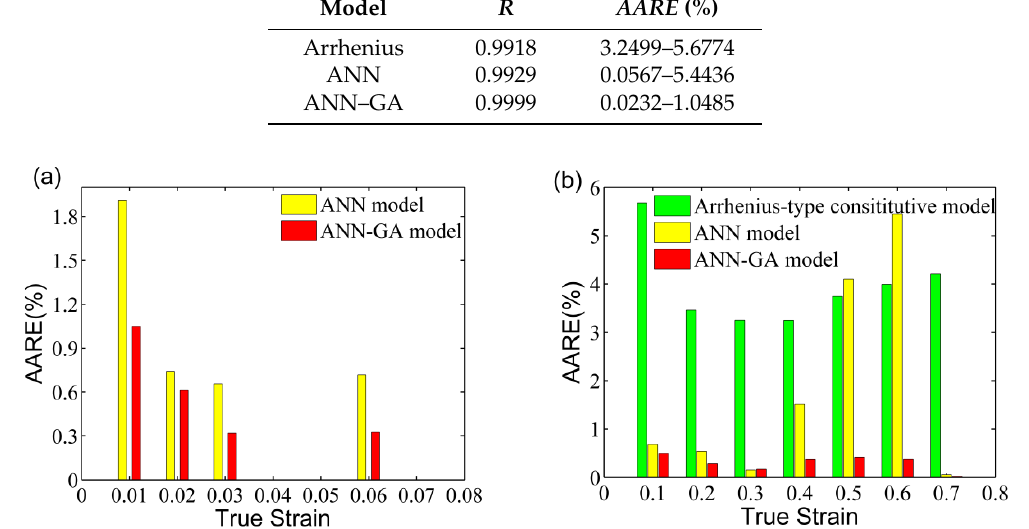
Figure 13. The AARE of the ( a ) BP–ANN and ANN–GA models at true strains of 0.01 – 0.06; and ( b ) Arrhenius, BP–ANN, and ANN–GA models at true strains of 0.1 – 0.7.